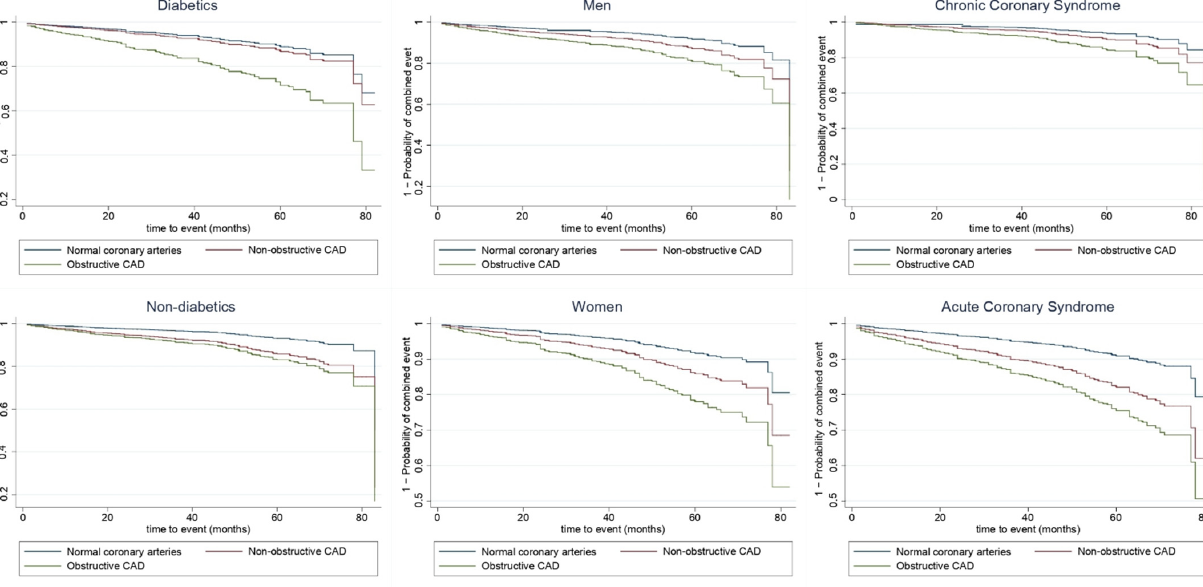
Figure 2. Adjusted Kaplan–Meier curves for combined event (acute myocardial infarction, stroke, hospitalization for heart failure or cardiovascular death) according to the degree of CAD using Cox proportional hazards regression stratified by diabetes, sex and indication for angiography. Models are adjusted by smoker, high blood pressure, dyslipidemia, diabetes (except for models stratified by diabetes), heart failure, kidney failure, indication for angiography (except for models stratified by indication for angiogrphy), atrial fibrillation, and left ventricular ejection fraction. CAD: coronary artery disease.